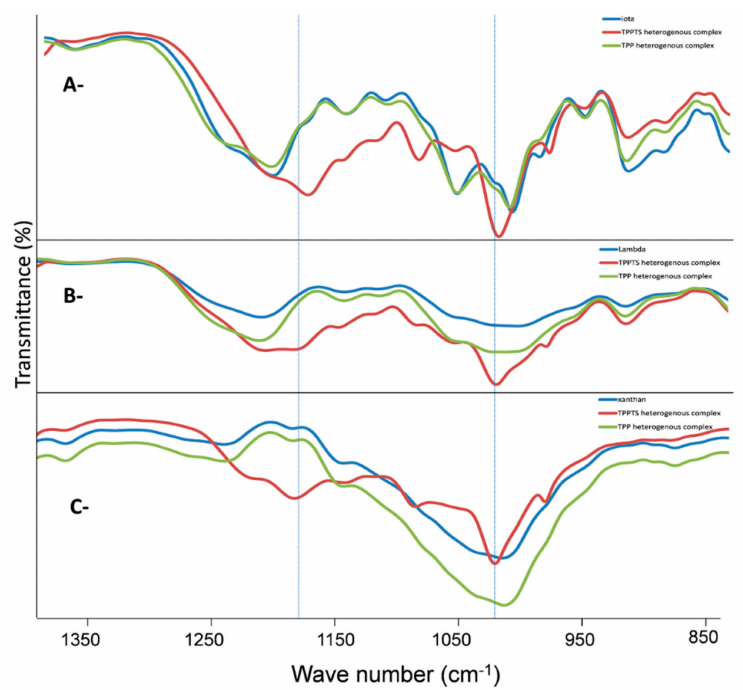
Figure 4. Infrared spectra of native polysaccharide and polysaccharide with PdCl 2 (TPP) 2 and PdCl 2 (TPPTS) 2 : ( A ) i , ( B ) λ , ( C ) X .